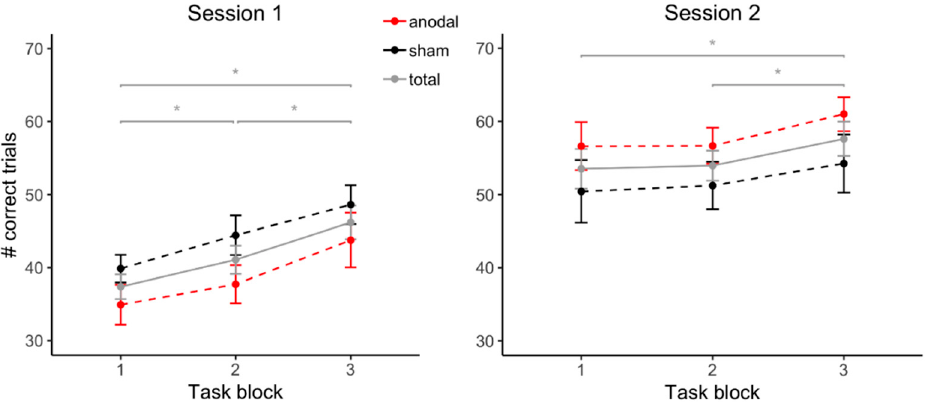
Figure 1. Task performance during each session with regard to stimulation condition. As the order of received stimulation (‘anodal/sham’ or ‘sham/anodal’) was a between-subject factor, participants receiving anodal stimulation during the first session ( n = 21) received sham stimulation during their second session, and vice versa ( n = 21). Error bars depict standard errors of the mean; asterisks mark p < 0.05.